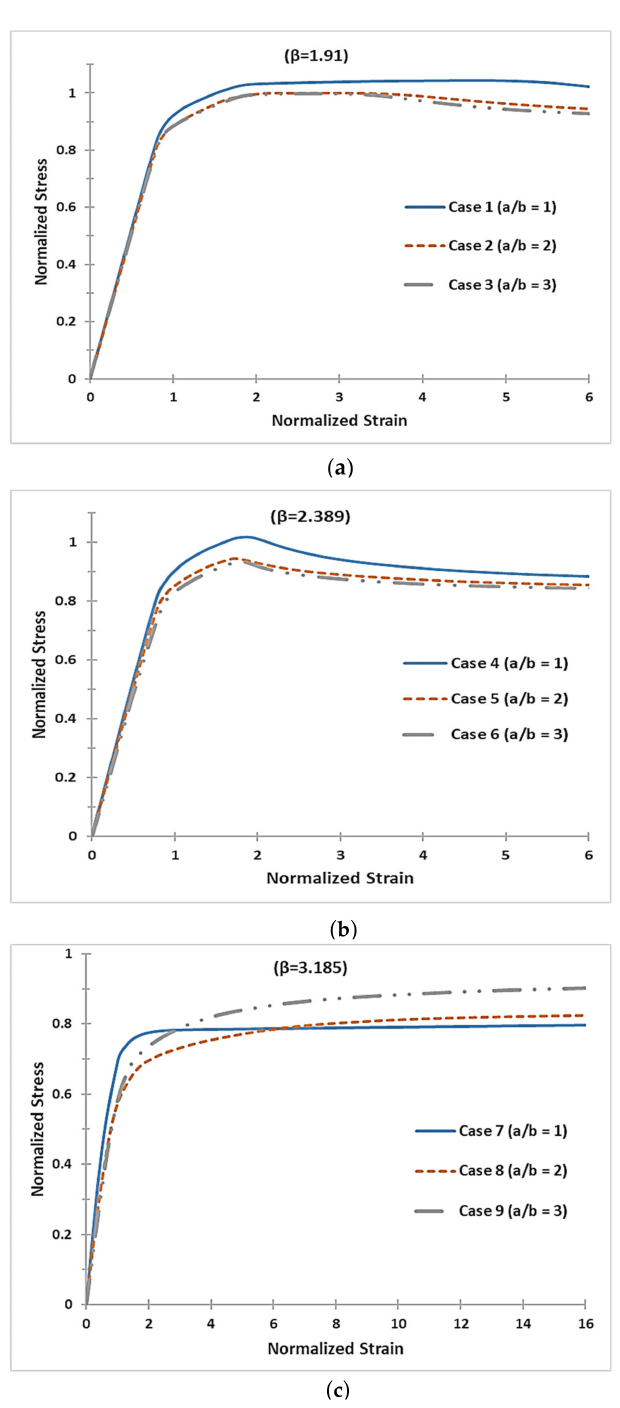
Figure 13. Load-shortening curves for 9 cases with the effect of welding imperfections ( a ) plate slenderness ratio β = 1.91, ( b ) plate slenderness ratio β = 2.389 and ( c ) plate slenderness ratio β =